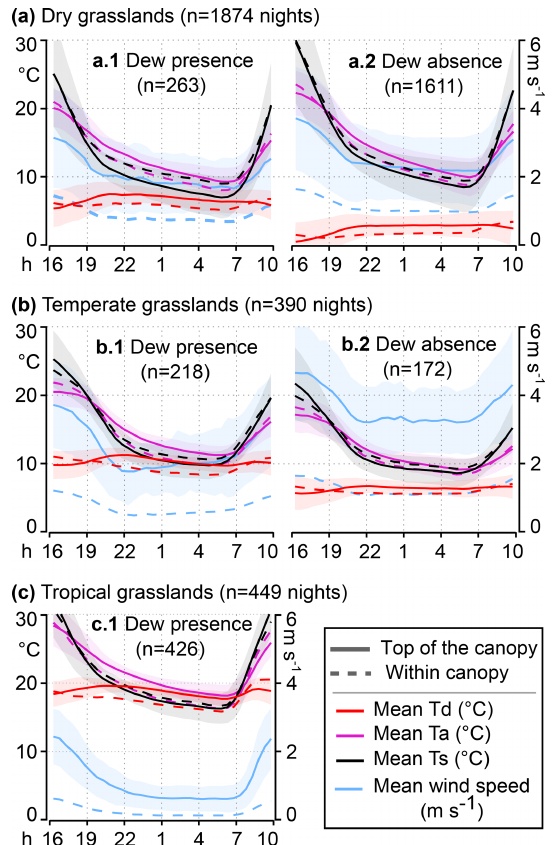
Figure 9. Nocturnal cycles for three populations of grasslands with the mean value of meteorological parameters calculated on a stack of n nights ( n indicated in parenthesis). The solid lines represent the top of the canopy, and the dashed lines represent within canopy. The shaded areas indicate ± 1 standard deviation of the mean, shown for the top of the canopy only (for visualization purposes). (a.1) , (b.1) , and (c.1) are based on nights with dew formation, and (a.2) and (b.2) are based on nights without dew formation. (c.2) is missing because of a sample size that is too